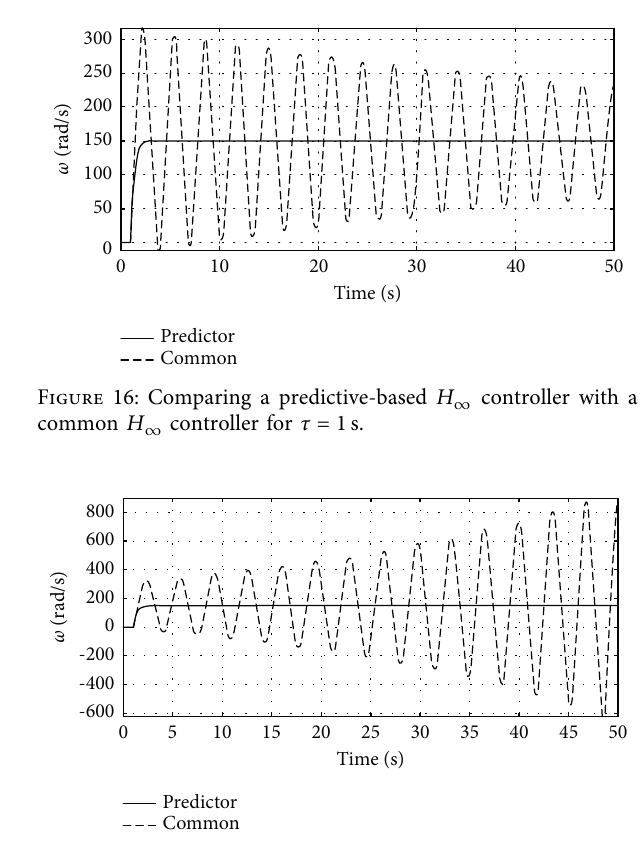
controller with a ∞